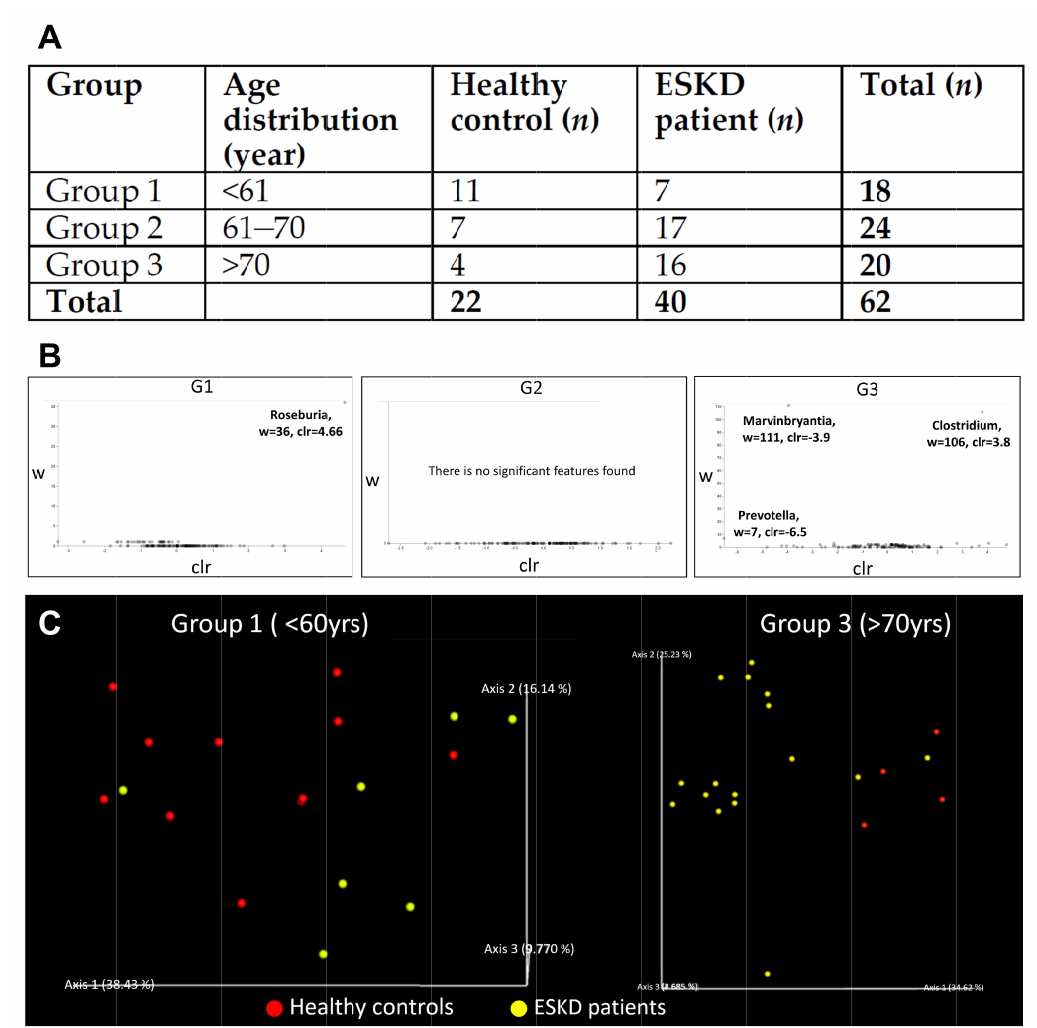
Figure 2. ( A ) Descriptive characteristics of the study population. ( B ) Differential abundance analysis of microbial at the genus level. ( C ) Multidimensional scaling ordination plot of the fecal bacterial community. The overall bacterial compositions can be used to separate most ESKD patients and healthy controls into two groups. (G1) Most ESKD patients were separated from healthy controls with only one exception. (G3) In the elder group, ESKD patients were separated from healthy controls. UniFrac distance metric was used to calculate the pairwise distances between samples. Healthy controls and ESKD patients were shown in red and yellow,